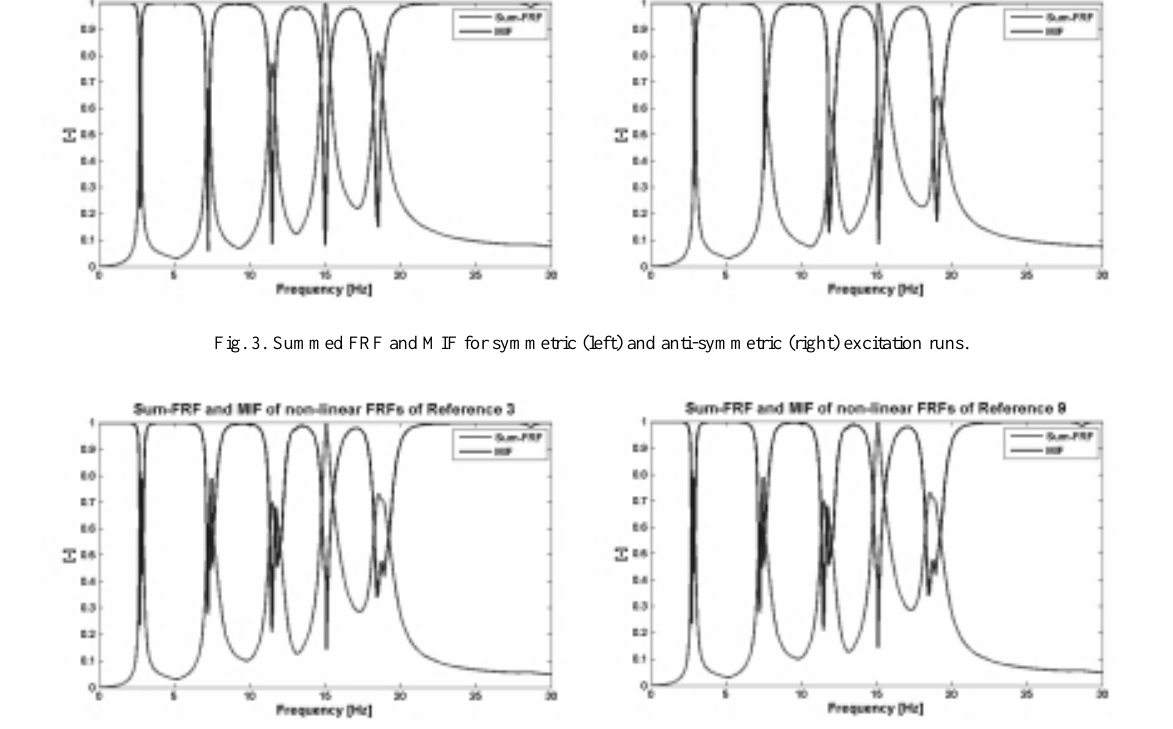
Fig. 4. Summed FRF and MIF for conventional FRF responses related to Dof #3 (left) and DoF #9